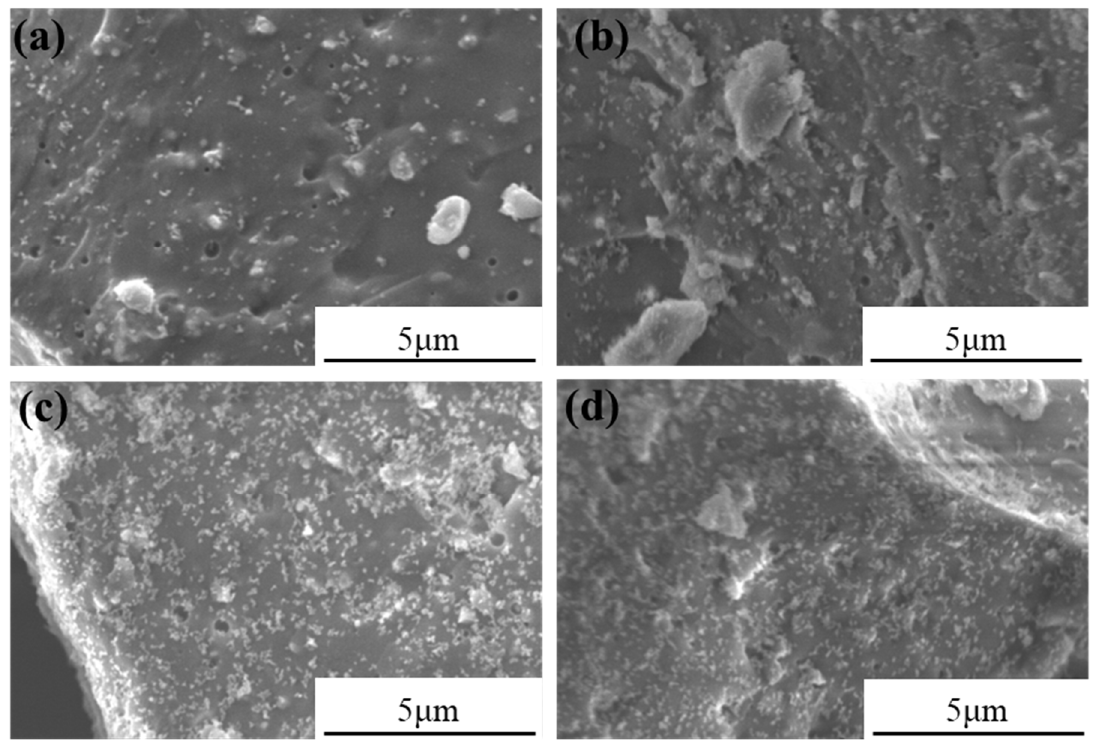
Figure 10. SEM images of 10% Epoxy with different LOA ( a ) 0.3%; ( b ) 0.5%; ( c ) 1.0%; ( d ) 1.2%.